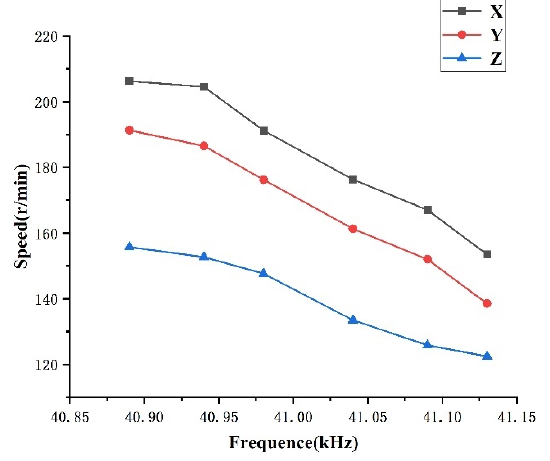
Figure 18. Mixed speed.